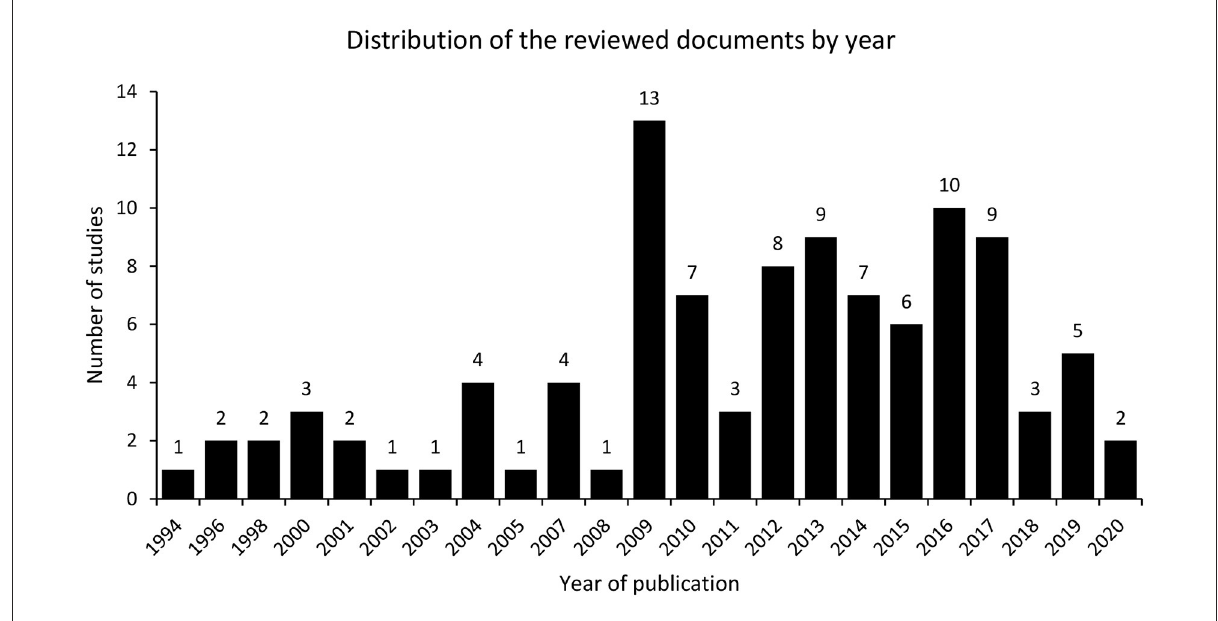
FIGURE3 Temporal distribution of the publications assessed in this